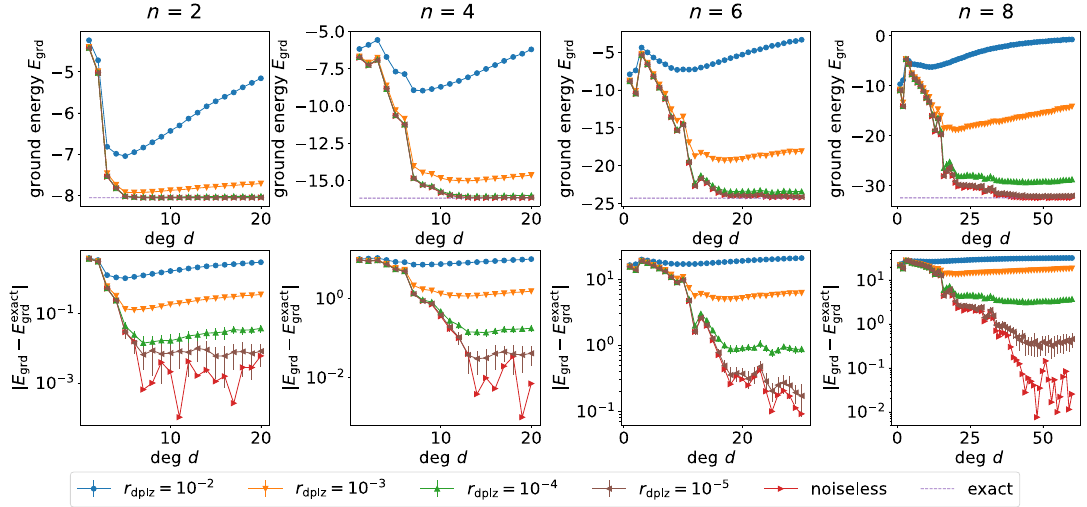
FIG. 6. Estimation of the ground-state energy of the TFIM model using QETU. Each marker labels the data simulated with a given of the spin system. In each column, the number depolarizing error rate r dplz . The dashed line is the exact ground-state energy E exact grd of qubits n is shown. The (red) right triangles denote the data computed from the best polynomial approximation by the convex- optimization solver, which only include the approximation error and are independent of quantum noise. The error bar denotes the standard deviation estimated from 30